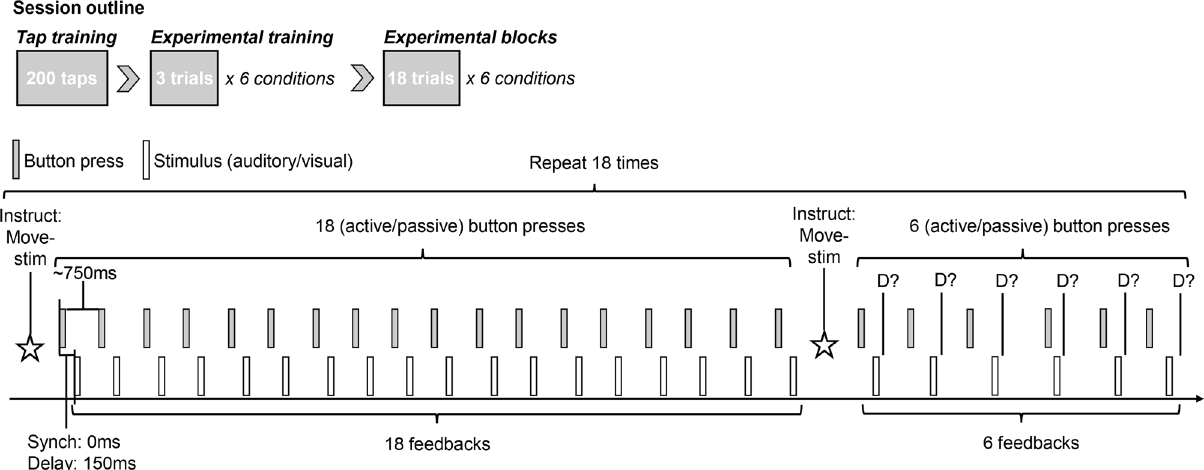
Figure 6. Outline of an experimental session (top). Each session consisted of a tap training block and six experimental training blocks, followed by six experimental blocks. Timeline of an experimental trial (bottom). Each trial consisted of an adaptation phase and a test phase, each preceded by instructions ( instruct ) on the movement type ( move : active or passive) and sensory feedback received ( stim : auditory or visual). Adaptation phase consisted of 18 button press-feedback pairs, with (150 ms) or without (0 ms) a systematic delay between the two. Test phase consisted of six button press-feedback pairs, each of which involved variable delays (0–334 ms) in between. Immediately after the button press-feedback pair, the participants were asked to judge whether there was a delay between these two events ( D?